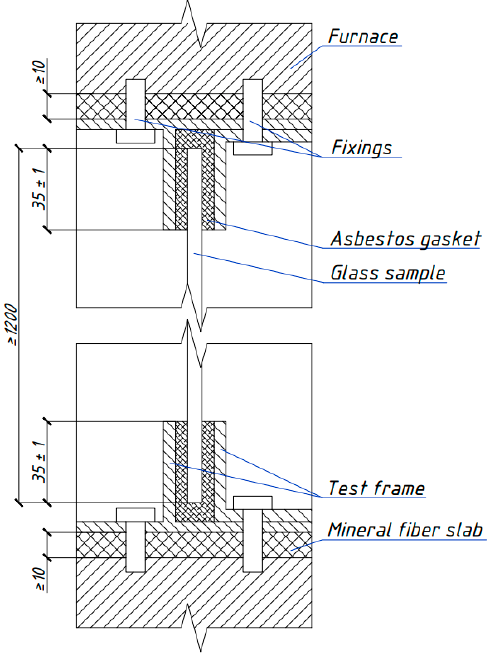
Figure 2. Scheme of sample installation in the furnace using the test frame. The installation diagram of a double-glazed window in a steel and aluminum profile is shown in Figure 3.